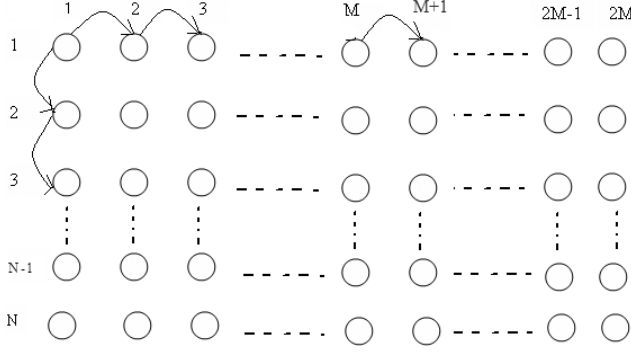
Fig. 1. Electrons moving in a lattice N (cid:1) 2 M .